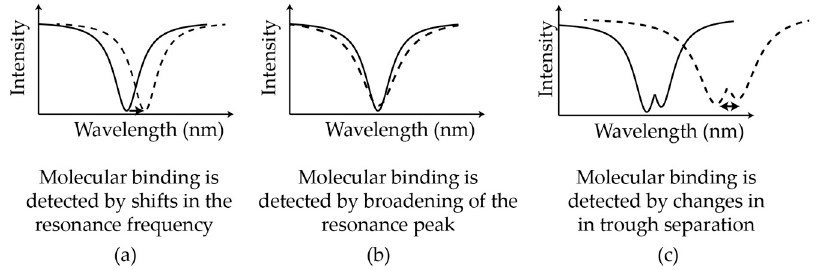
Figure 5. Summary of different sensing modalities: ( a ) particle binding events are detected by measuring shifts in the resonance frequency of the optical cavity; ( b ) binding events are detected by broadening of the resonance peak, reflecting a drop in the quality factor of the cavity due to scattering; and ( c ) particle binding is sensed by measuring changes in trough separation of a resonance doublet. These doublets are created by scattering caused, for example, by the deposition of a nanoparticle on the resonator surface.